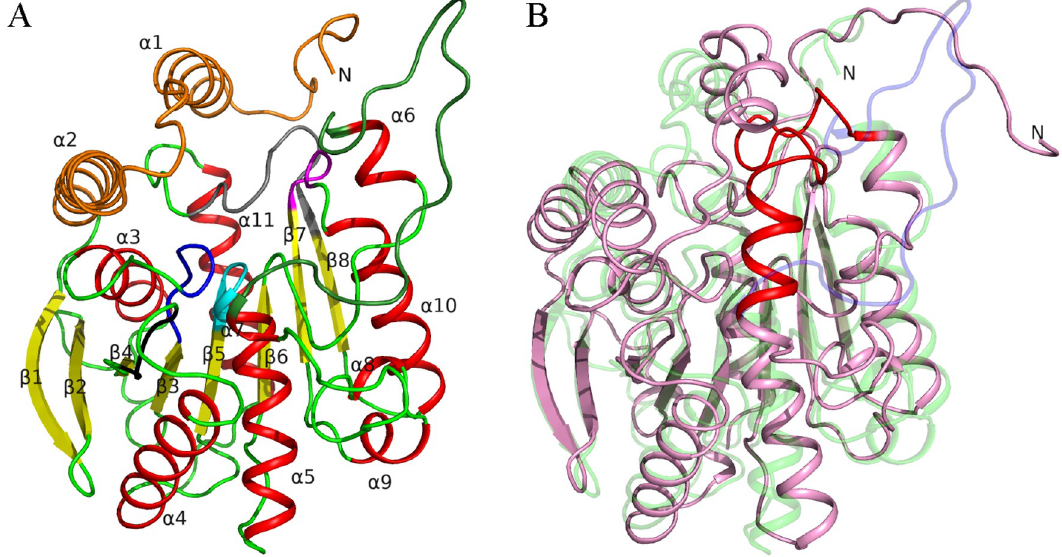
Fig 1. Structure of PMGL2 esterase. (A) Cartoon diagram of the wtPMGL2 subunit. Secondary structure elements are color coded ( α -helix—red; β -strand—yellow; loop—green). Characteristic sequence motifs are highlighted as followed: 105 HGGAF 109 (blue), 269 GGRD 272 (magenta), 296 FxxGxxHxxF 305 (grey), 172 GCSAG 176 (cyan) and 137 YRLA 140 (black). CAP-domain is highlighted in orange. The loop 216–237 is depicted in dark green. (B) Comparison of PMGL2 subunit (green, semitransparent) with homologous structure of esterase E25 from metagenomic library from the South China Sea (magenta, PDB entry 4Q05). Orientation of the wtPMGL2 is similar to panel A. Loop 216–237 of wtPMGL2 is highlighted in blue and corresponding loop of 4Q05 –in